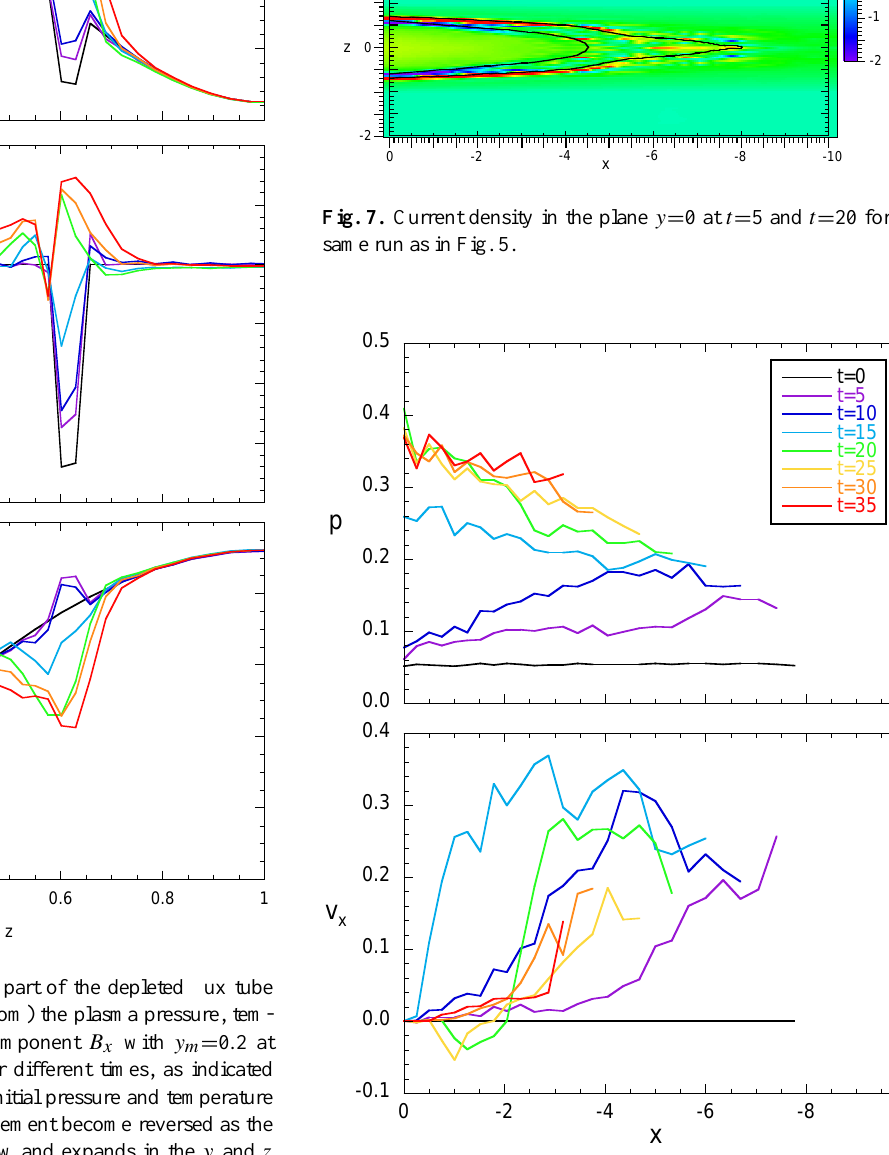
Fig. 8. Evolution of a depleted flux tube with y m = 0 . 2, showing (from top to bottom) the pressure and the velocity v x inside the depleted flux tube as functions of x for different times, as indicated by the color coding and the labels given in the top